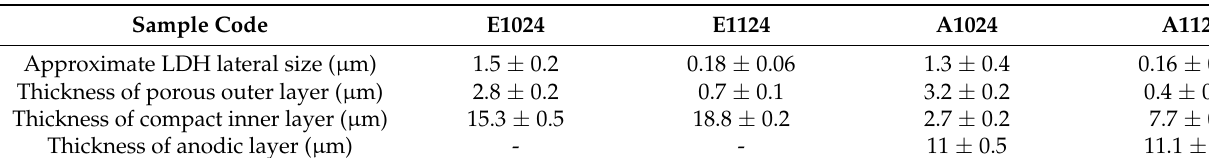
Table 3. Approximate LDH lateral size and thickness of different layers.